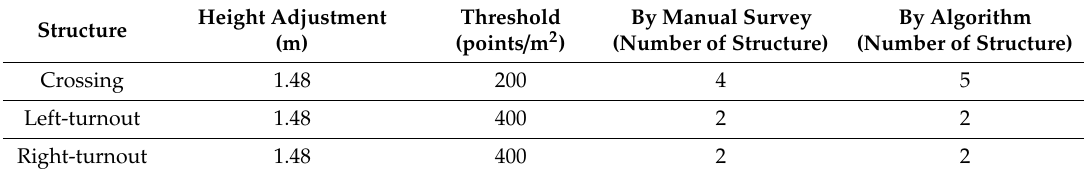
Table 3. Structure detection results—Railway line A.